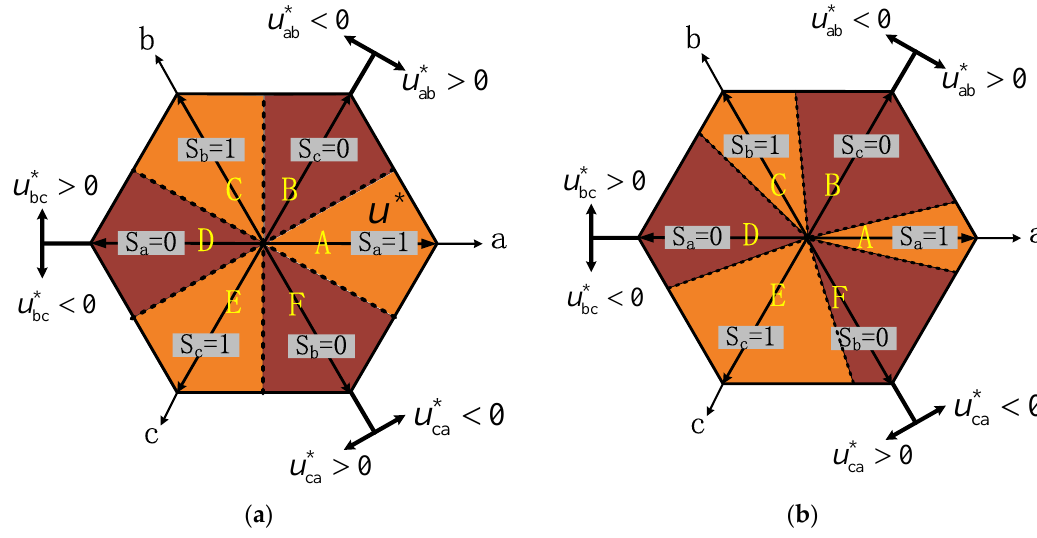
Figure 8. The flexible division of the voltage-space-vectors diagram combined with mode 0 and mode 1. ( a ) Symmetry division; ( b ) asymmetry division. Table 2. The detailed control strategies based on the flexible division. Sub-Regions Control